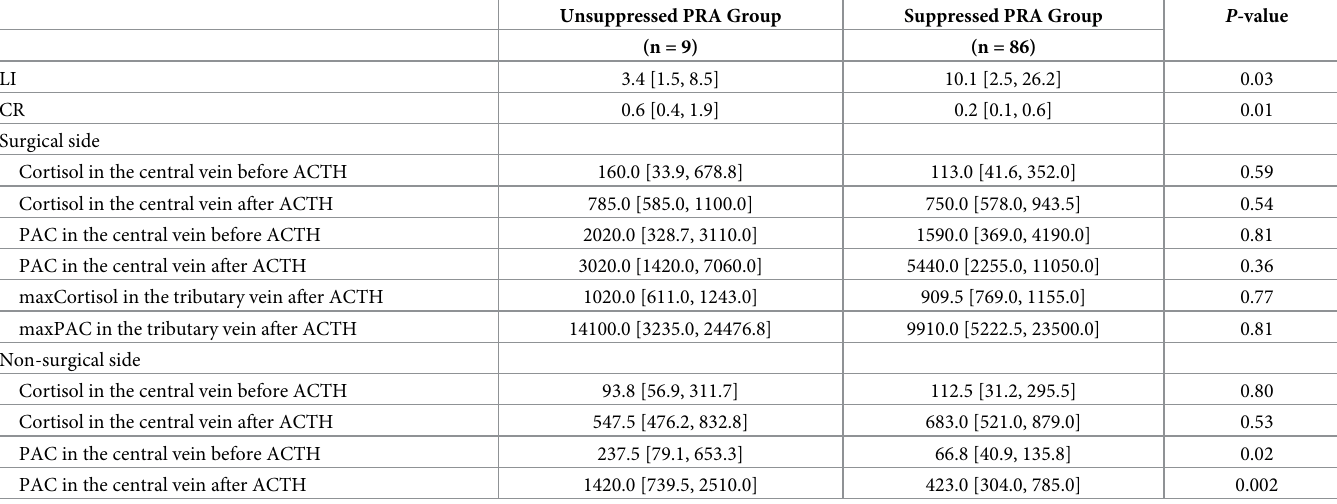
Unsuppressed PRA